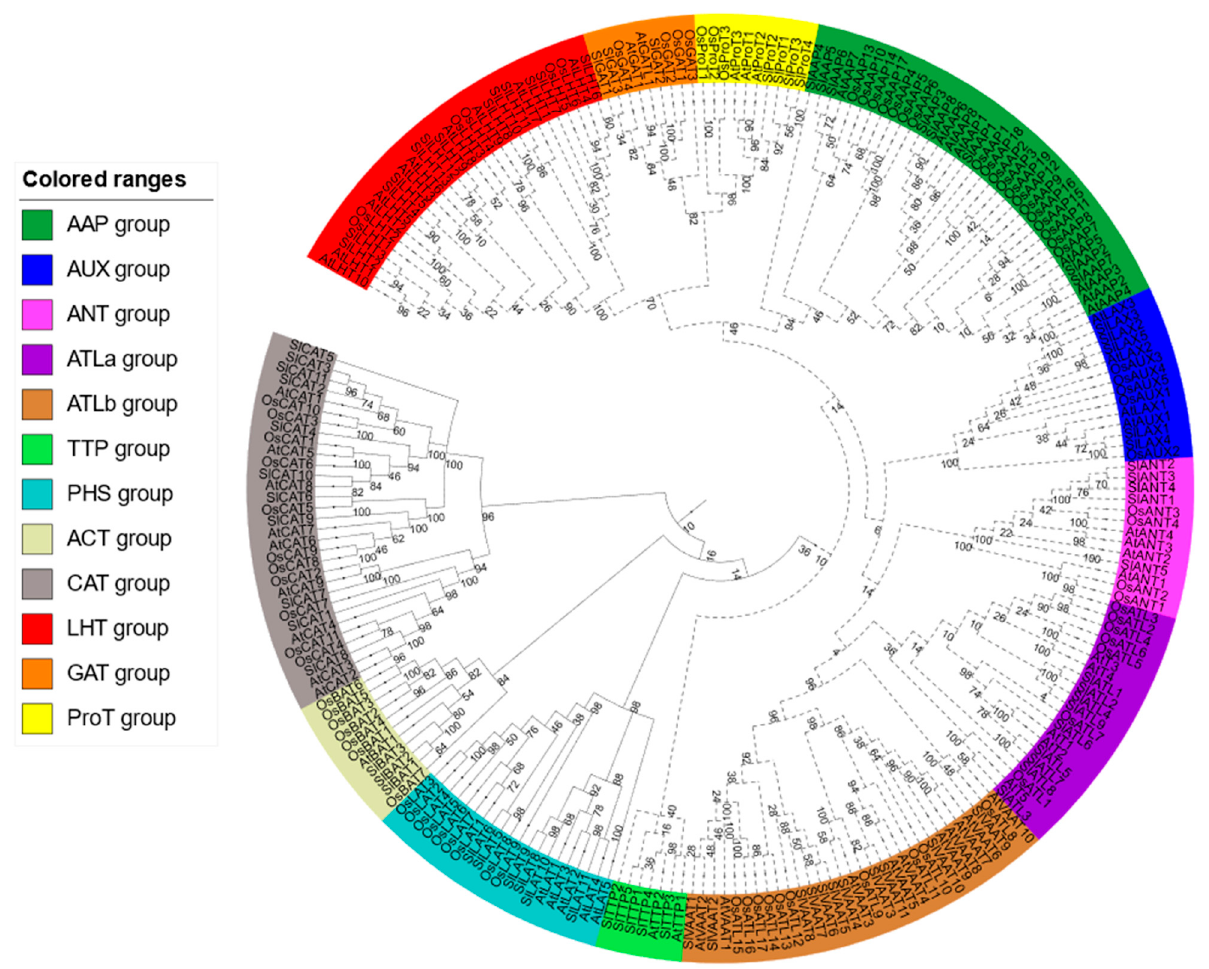
Figure 3. Phylogenetic tree of protein sequences of the AATs of Solanum lycopersicum , Oryza sativa , and Arabidopsis thaliana generated using MEGA 6.0 software with the Maximum Likelihood method and Whelan and Goldman model [35]. The bootstrap consensus tree inferred from 500 replicates is taken to represent the evolutionary history of the SlAATs analyzed. The tree was divided into 12 subgroups, marked by different color backgrounds. AAP, amino acid permease; ANT, aromatic and neutral amino acid transporter; ATL, amino acid transporter-like proteins; BAT, bidirectional amino acid transporter; CAT, cationic amino acid transporter; GAT, γ -aminobutyric acid transporter; LAT, L-type amino acid transporter; LAX, like-auxin influx carriers; LHT, lysine/histidine transporter; ProT, proline transporter; TTP, tyrosine-specific transporter; VAAT, vesicular aminergic-associated transporter; JTT, Jones–Taylor–Thornton. Dashed lines: AAAP family, Solid lines: APC family.